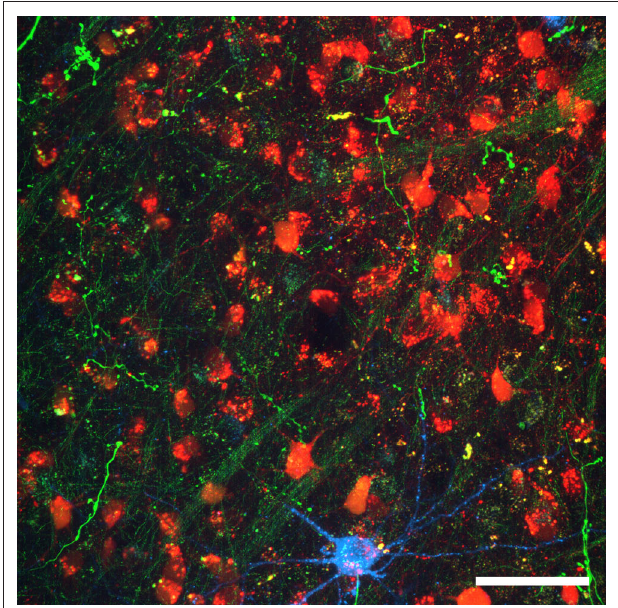
Figure 2 | Confocal image stack of HVC region (maximum intensity projection). Injections of three different tracers in afferent and efferent brain regions of HVC reveal distinct neuron types. RA-projecting neurons filled with Lucifer yellow are visible in red, Area X-projecting neurons filled with Alexa Fluor 647 in blue, and axons from Uva filled with Fluororuby in green. Scale bar: 50 μm.